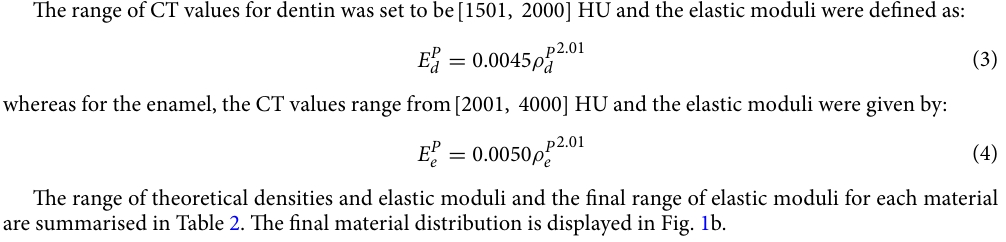
where the material density was set to be within [1001, 2000] kgm − 3 and the corresponding greyscale values were [501, 1500] HU .